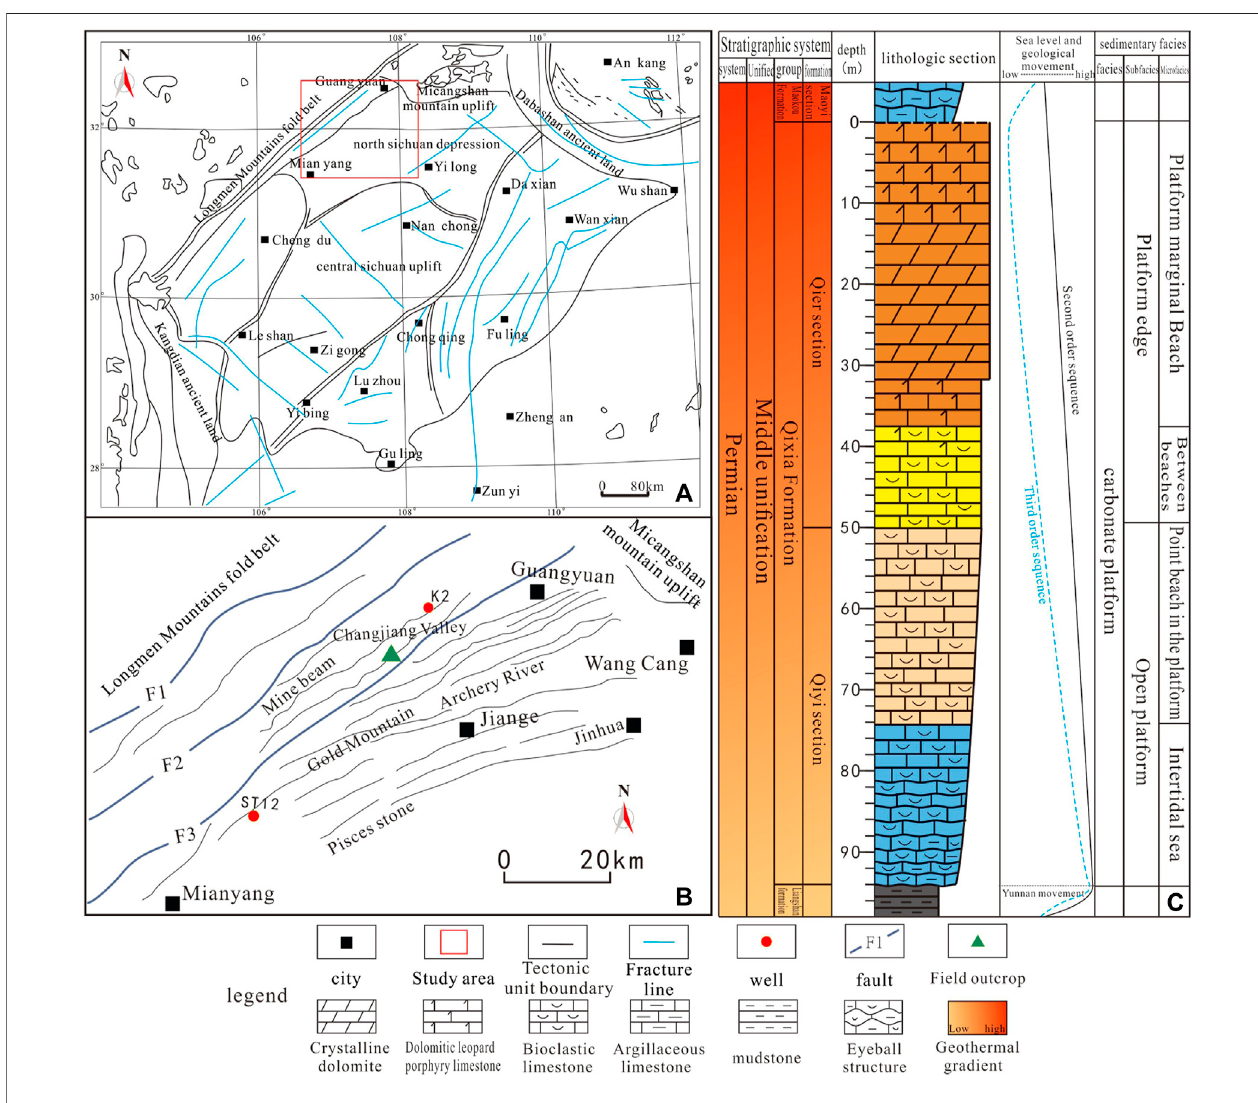
FIGURE 1 | Geology and lithology histogram of the study